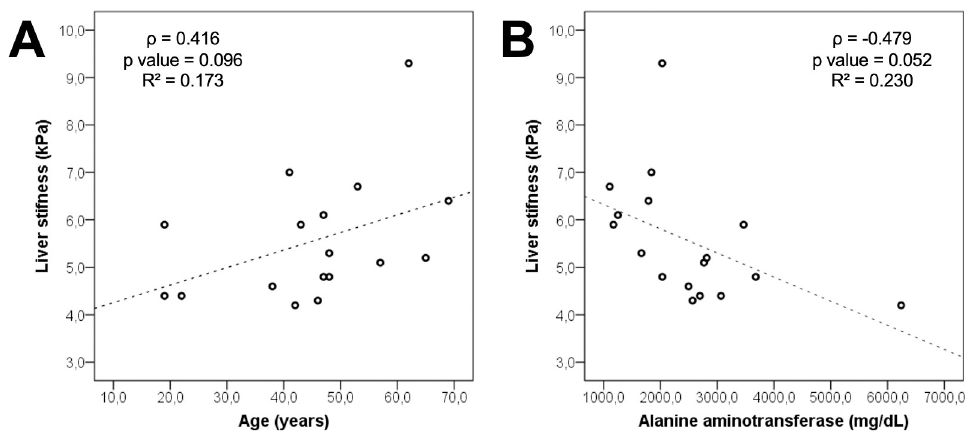
Table 3. Clinical and laboratory data at hospitalization according to liver fibrosis staging (with or without signifi- cant fibrosis) of 18 patients at 6 months after onset of symptoms of severe yellow fever, Brazil, 2018. Variable